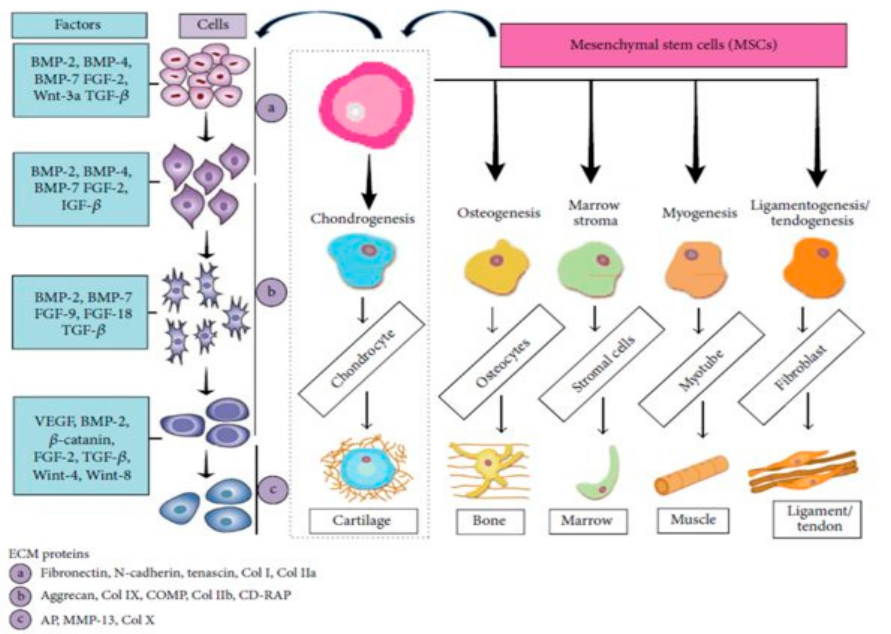
Figure 1. MSCs differentiation types and growth factors of various cell types. Illustration of ECM proteins at various stages [41].